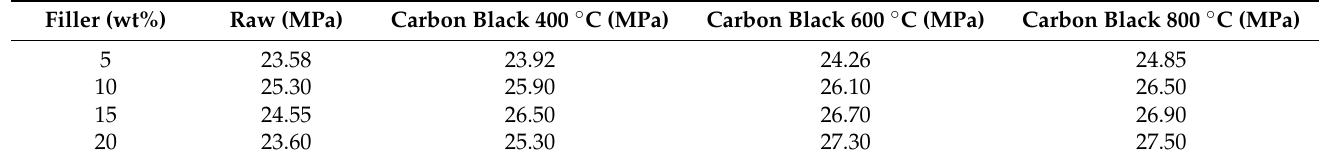
Table 4. Hardness values of WAS carbon black and polymer composites [86].